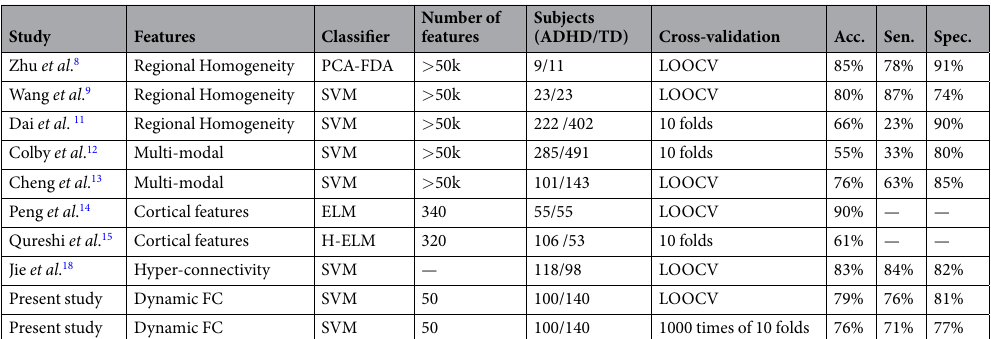
Table 3. Performance of previous methods and our method.